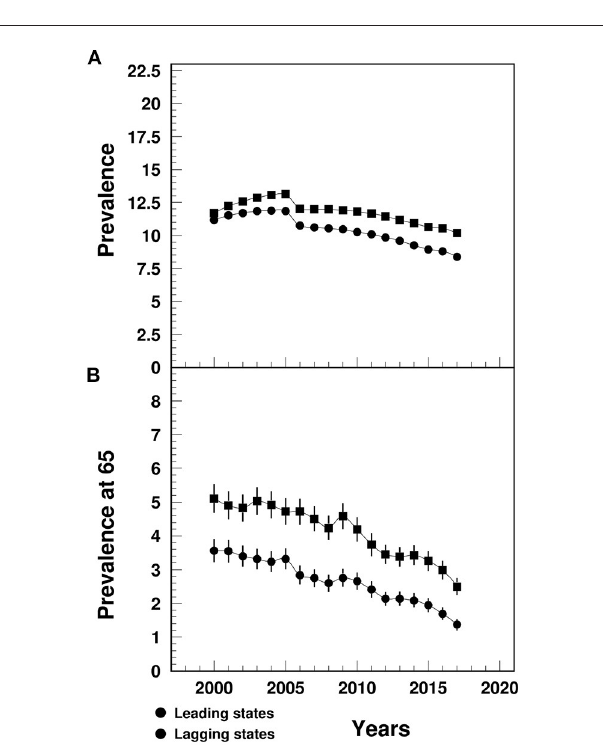
FIGURE 3 | Temporal trend of MI prevalence (A) among people aged 65 + and prevalence at age 65 (B) (%) in the U.S. leading and lagging states. Note: 1 Data were derived from 5% Medicare Beneficiaries. 2 The sudden decline in 2005–2006 that mainly occurred among females could potential be contributed from the Medicare Policy change (https://www.liebertpub.com/ doi/10.1089/jwh.2012.3777). 3 The 95%CI bars in (A) were too small to show up in the plot.